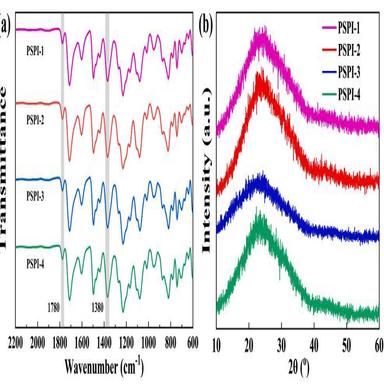
(a) FT-IR spectra of PSPIs (b) XRD pattern of PSPIs.